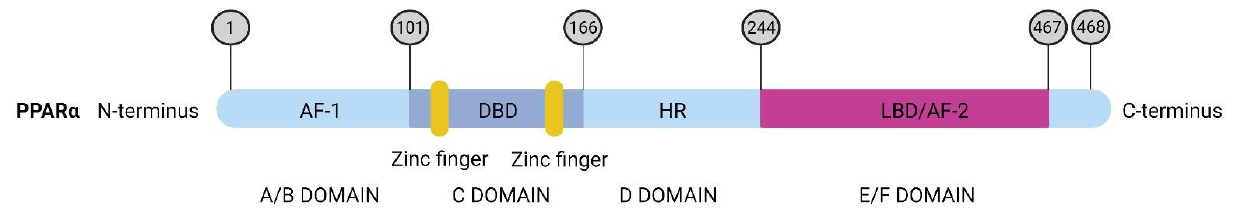
Figure 1. Schematic view of the protein structure of PPAR α and domain function. First there is the A/B domain or the activation function one (AF-1) domain which works without ligand binding. Next there is the C-domain or DNA-binding domain (DBD) containing two highly conserved zinc finger-like motifs shown in yellow. Following is the hinge region connecting the C domain with the last E/F domain, known as the ligand-binding domain (LBD) with the activation function two (AF-2).